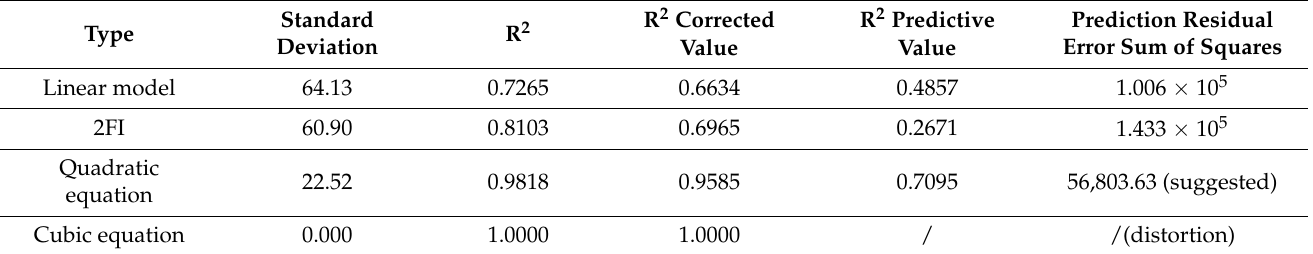
Table 10. R 2 comprehensive analysis.